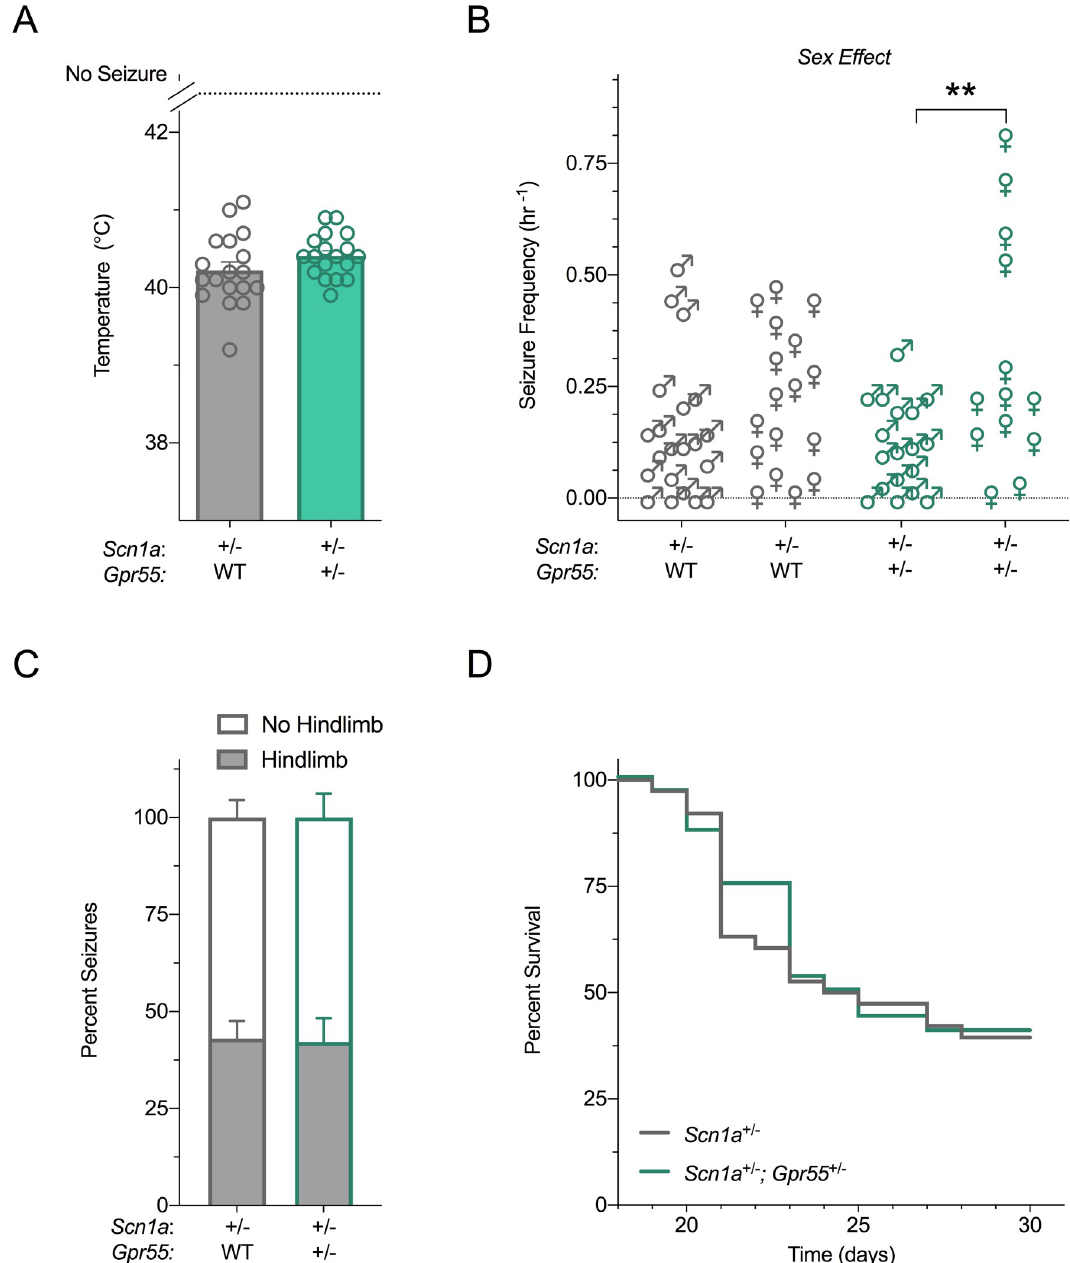
Fig 3. Genetic deletion of Gpr55 has little effect on F1. Scn1a +/- phenotype. ( A ) Threshold temperature of individual mice for GTCS induced by hyperthermia in male and female F1. Scn1a +/- (gray symbols) and F1. Scn1a +/- ; Gpr55 +/- (green symbols) mice. Heterozygous Gpr55 deletion had no effect on a thermally induced seizure of F1. Scn1a +/- mice. The average temperatures of seizure induction are depicted by the bars and error bars represent SEM, with n = 18 (9 males and 9 females) per group (Mantel-Cox logrank). ( B ) Spontaneous GTCS frequency of individual F1. Scn1a +/- (gray symbols) and F1. Scn1a +/- ; Gpr55 +/- (green symbols) mice. Unprovoked, spontaneous GTCS were quantified over a 60 h recording period, with n = 13–21 per group (n = 21, 17, 18, and 13, left to right). A sex-dependent effect was observed with female mice exhibiting a significantly higher spontaneous seizure frequency than male mice ( p < 0.005, two-way ANOVA). Female F1. Scn1a +/ ; Gpr55 +/- mice had a greater spontaneous seizure frequency than male F1. Scn1a +/- ; Gpr55 +/- mice ( �� p < 0.01, two-way ANOVA followed by Sidak’s test). ( C ) Proportion of spontaneous GTCS with (gray bars) or without (white bars) full tonic hindlimb extension is presented. Heterozygous Gpr55 deletion had no effect on spontaneous seizure severity of F1. Scn1a +/- mice (two-way ANOVA). ( D ) Survival curves comparing F1. Scn1a +/- and F1. Scn1a +/- ; Gpr55 +/- male and female mice. Heterozygous Gpr55 deletion had no effect on survival of F1. Scn1a +/- mice (Mantel-Cox logrank).